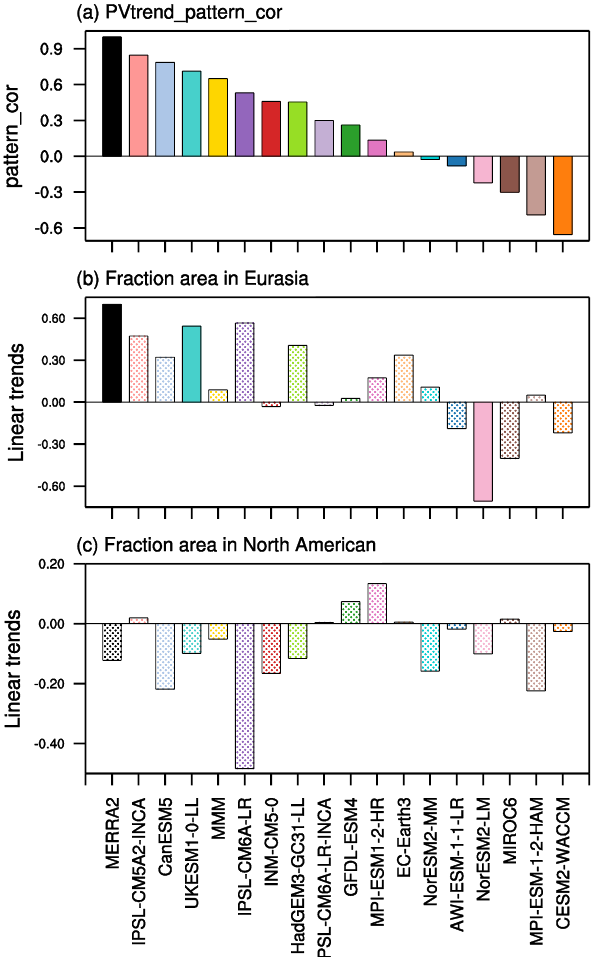
Figure 9. ( a ) Spatial correlation coefficient of PV trend over isentropic levels within 430–600 K in the Northern Hemisphere (30° – 90°N) between individual CMIP6 model simulations and MERRA2 for the period of 1981 – 2014 in February. Linear trends of fractional area over ( b ) Eurasian continent and ( c ) North America for the period of 1981 – 2014 based on MERRA2 and individual CMIP6 model simulations. The fractional area over a specific region (e.g., Eurasian or North American) is defined as the area of polar vortex in the region divided by the total area of the polar vortex. This definition is the same as that defined in Figure 1c of Zhang et al. [20]. The solid columns represent the corresponding linear trends that are statistically significant at the 90% confidence levels, whereas the dotted columns indicate trends that are not significant at the 90% confidence level. Each color column represents an individual CMIP6 model, while the black column denotes MERRA2.